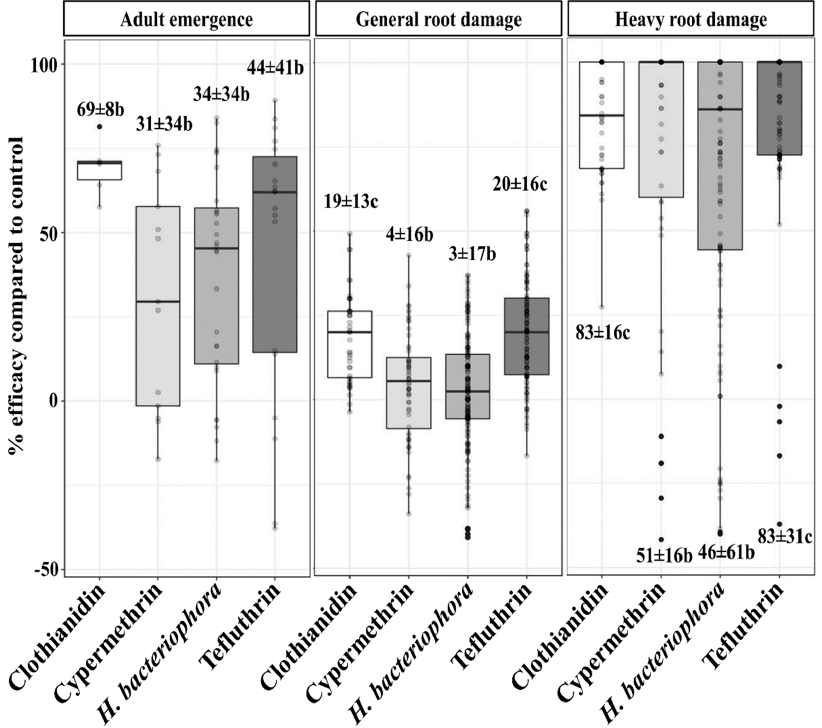
Figure 1. Efficacy of different treatments in controlling Diabrotica v. virgifera larvae and in preventing root damage in maize fields compared to the untreated, infested control. General root damage as- sessed via the 1.0 to 6.0 modified Iowa scale, and heavy root damage assessed via 0.00 to 3.00 Oleson’s node-injury scale. Pest population assessed by counting adults emerging from the soil in gauze cages. The spread of the data points represents the mean number of adults per field and the means of the general and heavy root damage per plot. The median is presented as a full line inside box plots; the mean ± the SD is presented as numbers above the boxes. Different letters on box plots indicate the significant difference as per post hoc Tukey HSD test at p < 0.05 following ANOVA; untreated, infested control significance letter is a, n = 20 sites, and the study was conducted across 10 years in southern